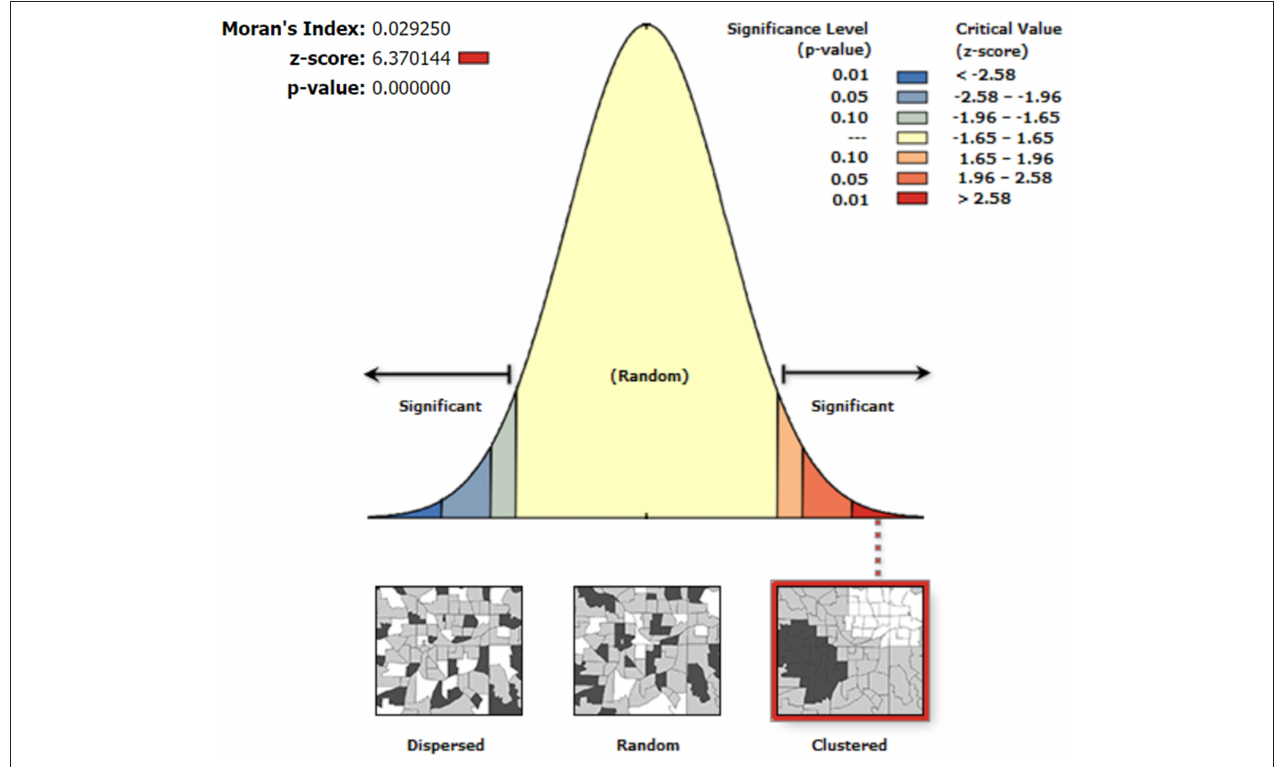
FIGURE 4 | Global spatial autocorrelation analysis of the mean serum SELENOP levels at the county-level. The left side of the figure represents dispersed areas, the right side represents clustered areas, and the middle represents random